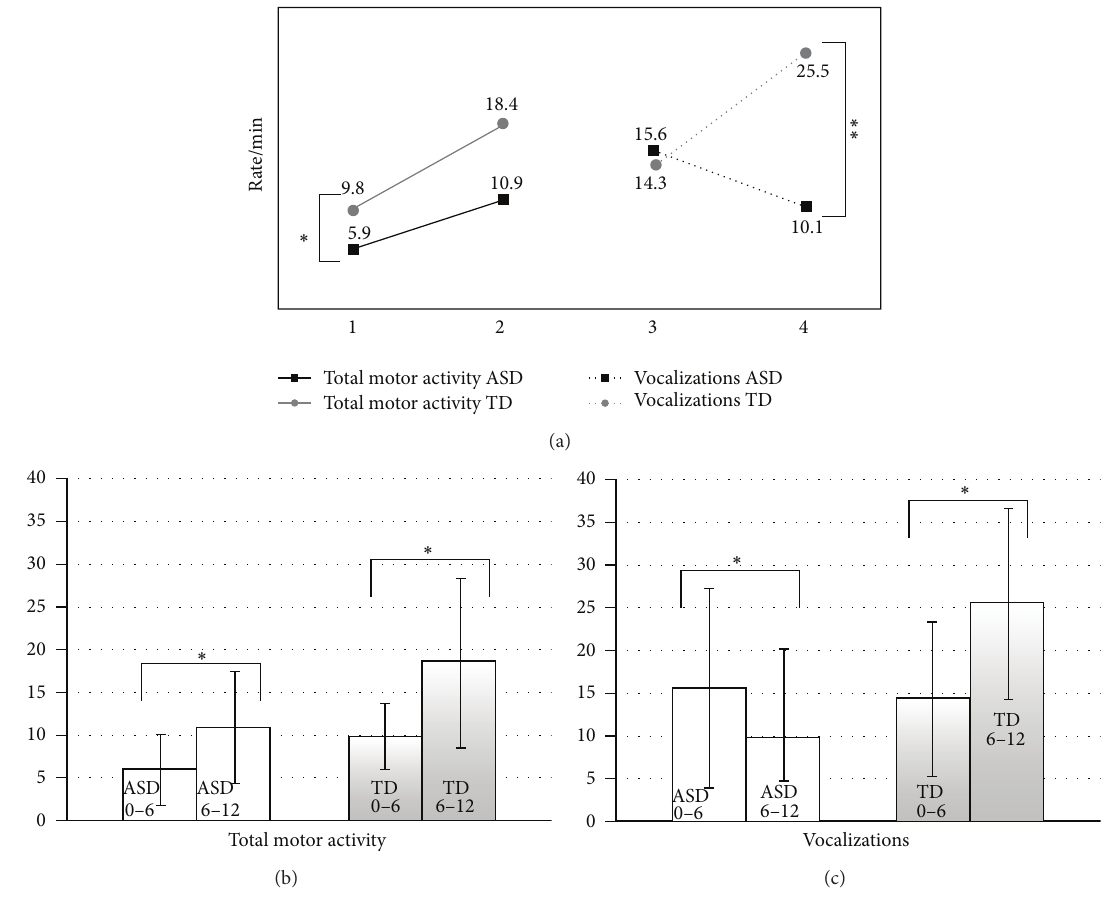
Figure 2: Trajectories of infant’s total motor activity versus infant’s vocalizations. (a) Trajectories (from T1 to T2) of total motor activity (b) and vocalizations total (c). Infants with ASD compared to TD infants show a reduced rate/min of motor activity at T1 and a reduced rate/min of vocalizations at T2. (b), (c) Means and standard deviations (error bars). ∗∗ 𝑃 ≤ 0.01 ; ∗ 𝑃 ≤ 0.05 .